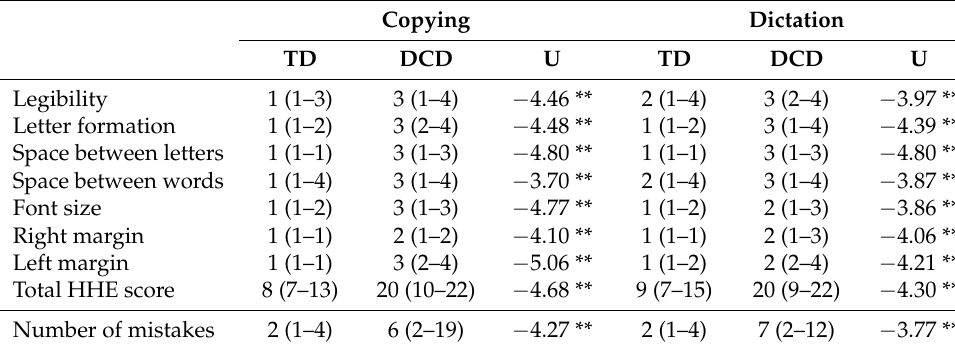
Table 2. Handwriting legibility and letter formation. Data are presented as median and range in parentheses. Mann–Whitney U analyses were performed (Standardised U reported).